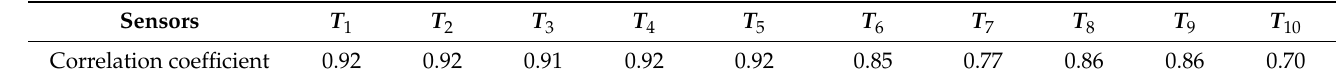
Table 3. Correlation coefficient between temperature variable and thermal error of K1.